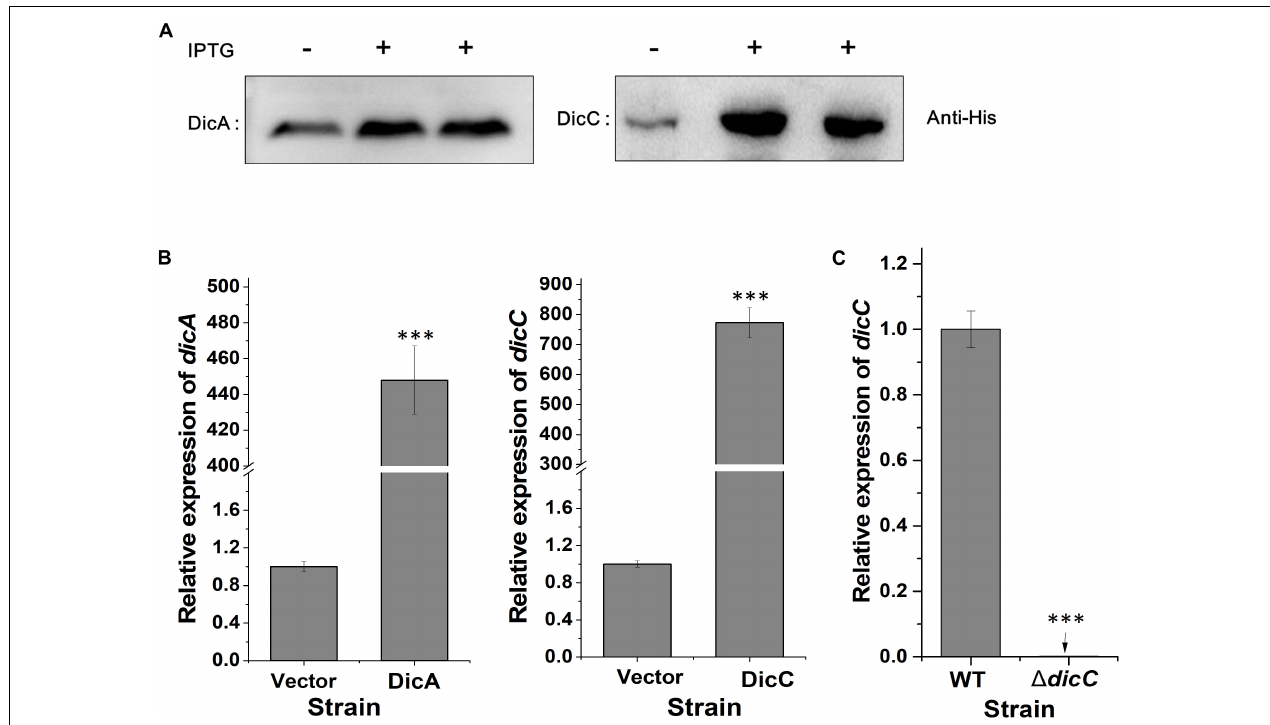
FIGURE 1 | Construction of the DicA- and DicC-overexpressing and (cid:49) dicC mutant strains. (A) Protein expression of DicA and DicC in recombinant strains induced by IPTG was confirmed by western blot analysis. (B) Detection of the dicA and dicC gene expression levels in the DicA and DicC recombinant strains by qPCR. (C) Detection of dicC expression in the (cid:49) dicC mutant strain by qPCR. Error bars show the standard errors of the means. Significance was calculated by the t -test ( ∗ p < 0.05, ∗∗ p < 0.01, ∗∗∗ p <